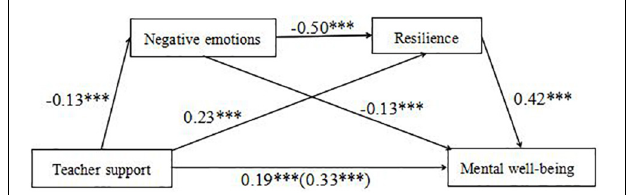
TABLE 2 | Direct, indirect, and total effects of teacher support on mental